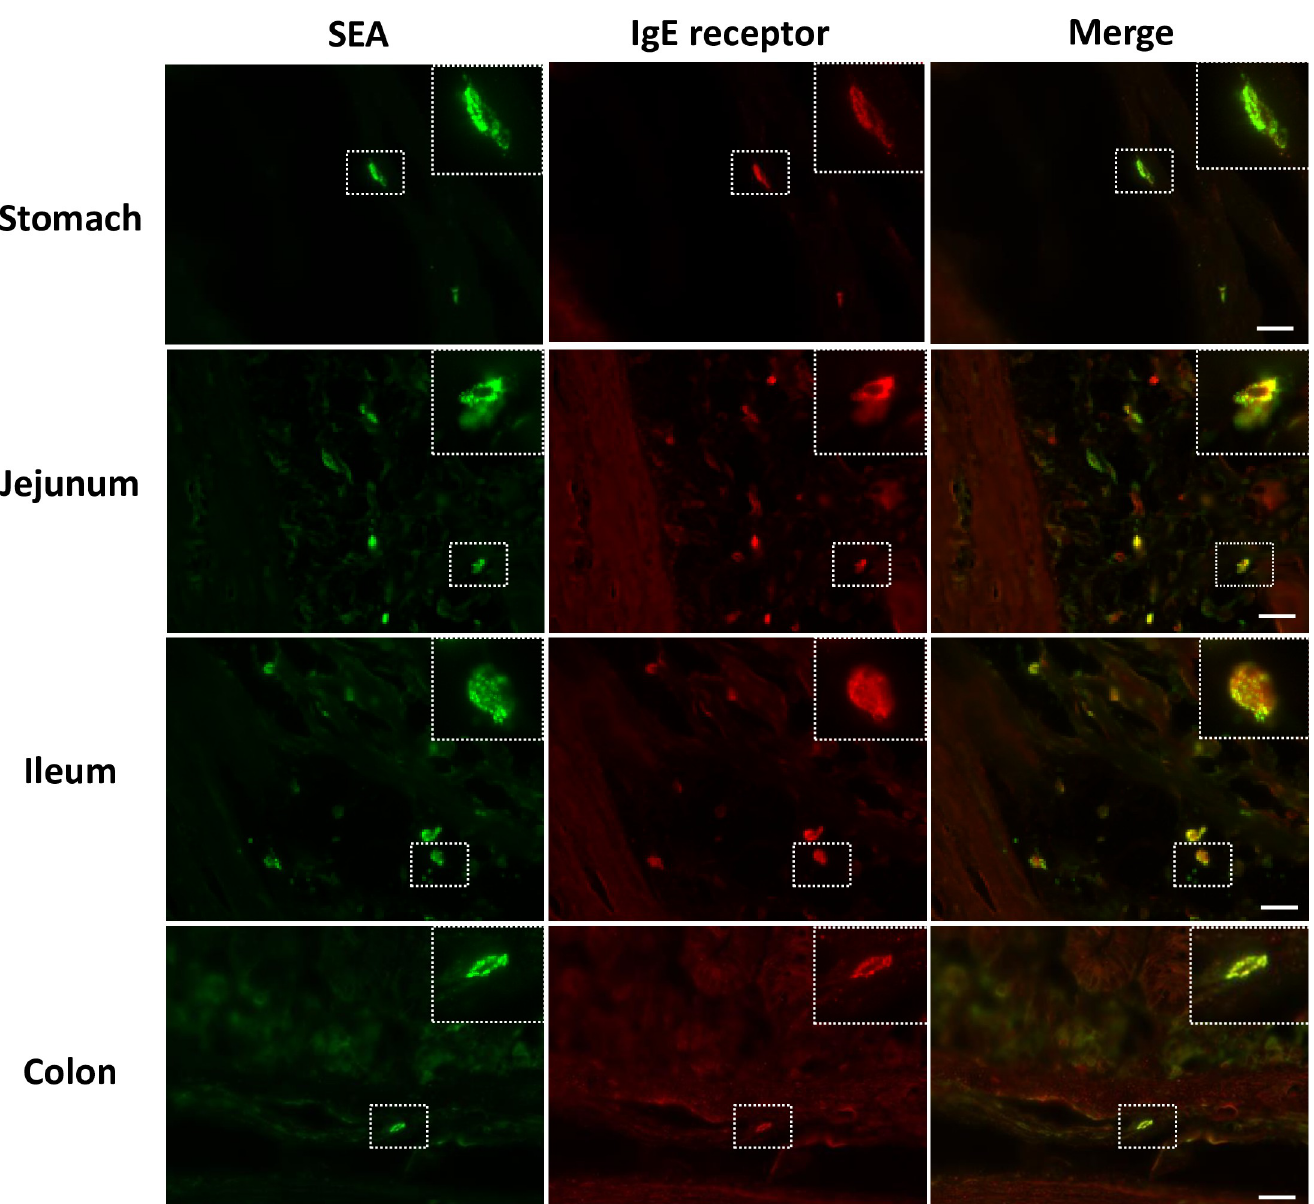
Fig 3. SEA binds with mast cells in the submucosa of the GI tract. Specimens of the intestinal tract were removed from a common marmoset. Frozen tissues were sectioned (10 μ m) and incubated with SEA (1.0 μ g/ml) for 60 min at room temperature. (A) GI sections were processed for double immunofluorescence staining using anti-SEA antibody (green) and anti-Fc ε RI α antibody (red), which detected the mast cell marker, IgE receptor. Each scale bar is equal to 20 μ m.